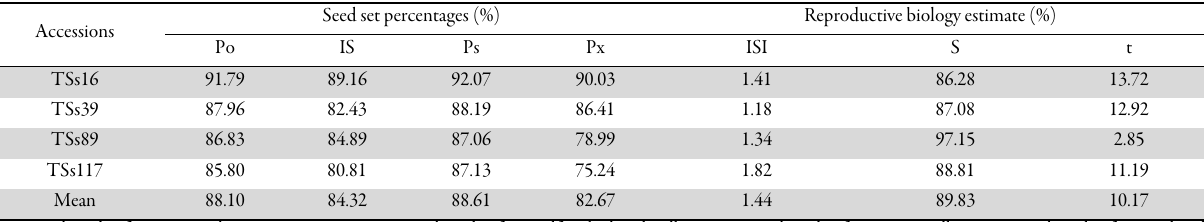
Table 4. Reproductive biology estimates of four accessions of African yam bean Seed set percentages (%) Reproductive biology estimate (%) Accessions Po IS TSs39